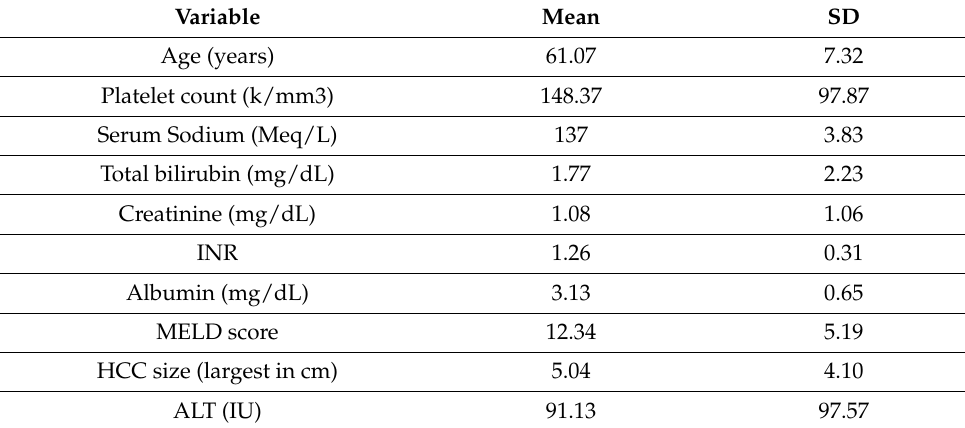
Table 2. Summary of findings on univariate analysis between Caucasian and AA patients with HCC at